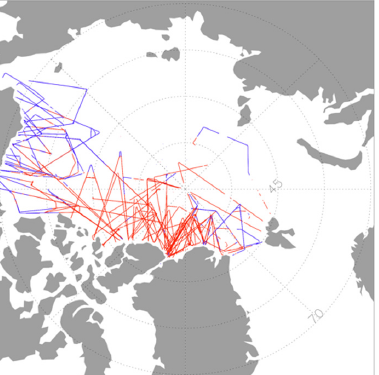
Figure 1. OIB ground tracks from 2009 to 2019. There are 94 spring flights over the Arctic Ocean. Land cover is in gray. Blue tracks are for first-year ice (FYI) and red tracks are for multi-year ice (MYI). FYI and MYI are based on OSISAF sea surface types [27]. The majority of the campaigns are between March and April. There are three campaigns from early May in 2015 and 2016. For overlapping tracks, later tracks will cover early